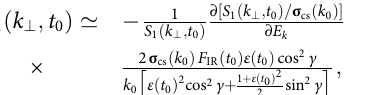
is perfectly polarized (cos 2 γ ¼ 1), the second pulse has unpo- larized component (cos 2 γ ¼ 0 : 85). The IR pulse carried at 800 nm was 7.2 fs long, with intensity I IR ¼ 3 : 5 ´ 10 12 W/cm 2 . To